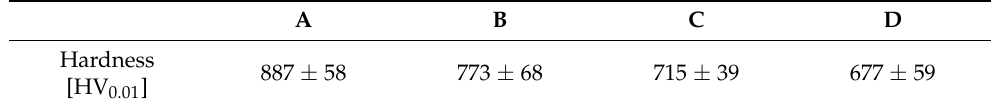
Table 10. Hardness of the sintered filaments/3D objects (1165 °C, 5 h). A B C D Hardness [HV 0.01 ]